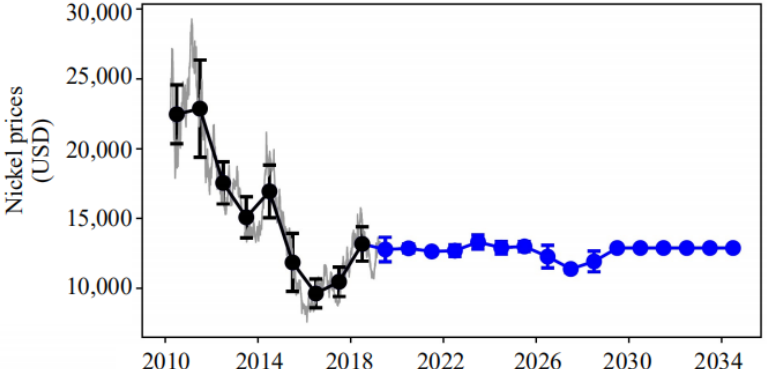
Figure 6. Forecast results of nickel price in the next 16 years.